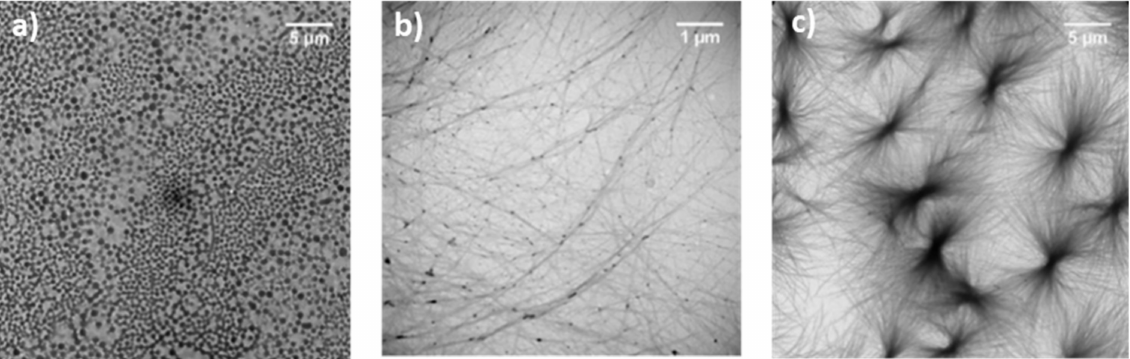
Figure 2. TEM images of ( a ) Boc- α ( S )Phe- α ( S )Phe-OH, ( b ) Boc- β 3 ( R )Phe- β 3 ( R )Phe-OH, and ( c ) Boc- γ 4 ( R )Phe- γ 4 ( R )Phe-OH in water at a concentration of 0.5 mg · mL − 1